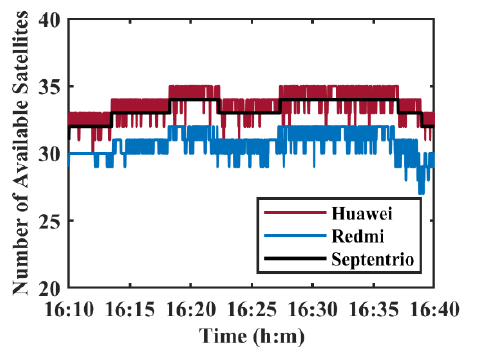
Figure 7. The time series of the number of available satellites in quad-constellation. Table 3. RMS of the quad-constellation velocity determination error. (Unit: m/s)